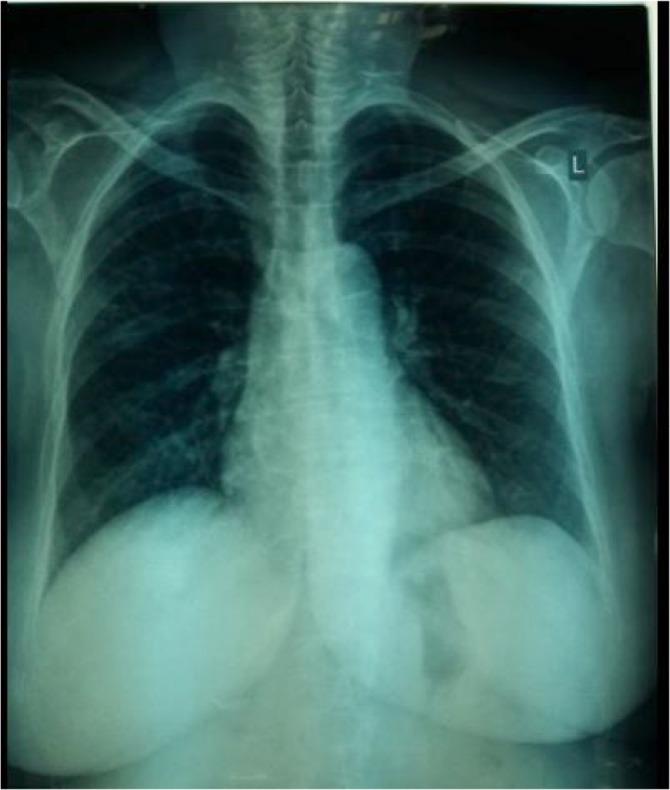
Chest radiograph on admission